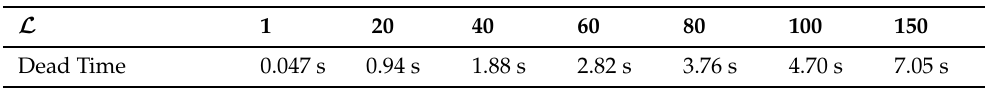
Table 1. The dead time in data acquisition, when the number of acquisition windows required for forming the sub-images is